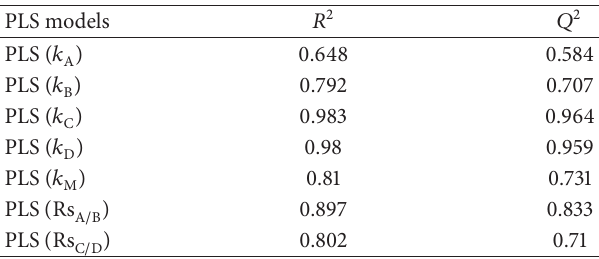
Table 1: Plan of experiments. Table 2: Statistical parameters of created PLS